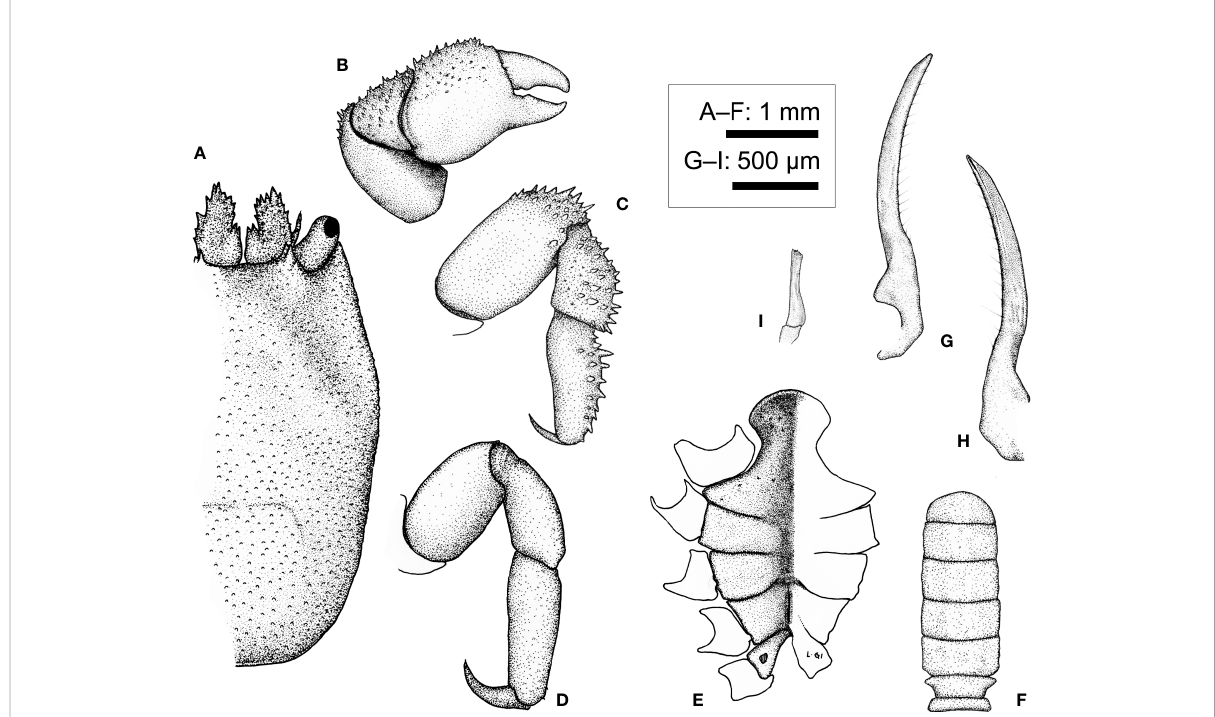
FIGURE 13 Lithposcaptus scottae sp. nov., male (CEL-Hapa-019). (A) carapace; (B) 1681 right P1; (C, D) right P2, P5, dorsal view; (E) thoracic sternites, left sternite 8 obscured base of left G1; (F) pleon; (G) right G1, dorsal view; (H) right G1, ventral view; (I) right G2, lateral